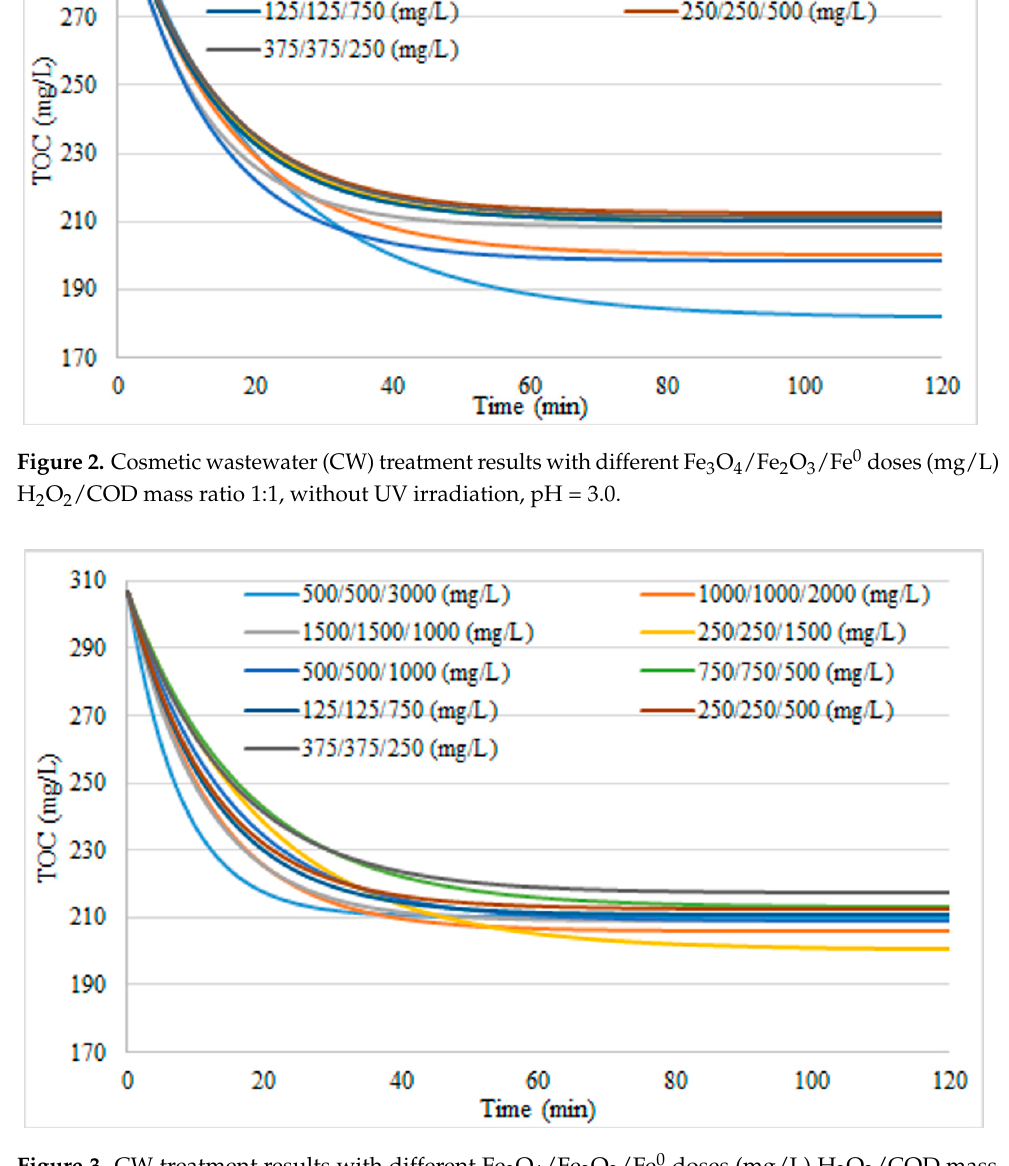
Figure 3. CW treatment results with different Fe 3 O 4 /Fe 2 O 3 /Fe 0 doses (mg/L) H 2 O 2 /COD mass ratio 2:1, without UV irradiation, pH = 3.0.